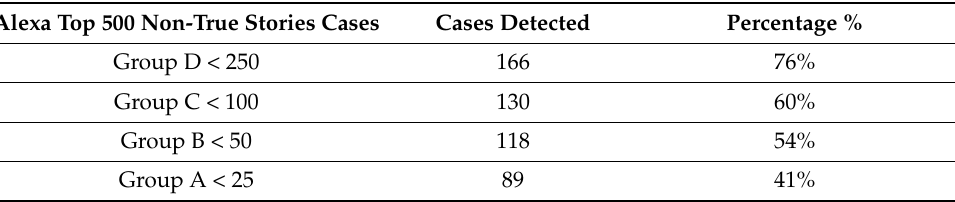
Table 4. Non-true stories cases detected/layers of popularity. Alexa Top 500 Non-True Stories Cases Cases Detected Percentage